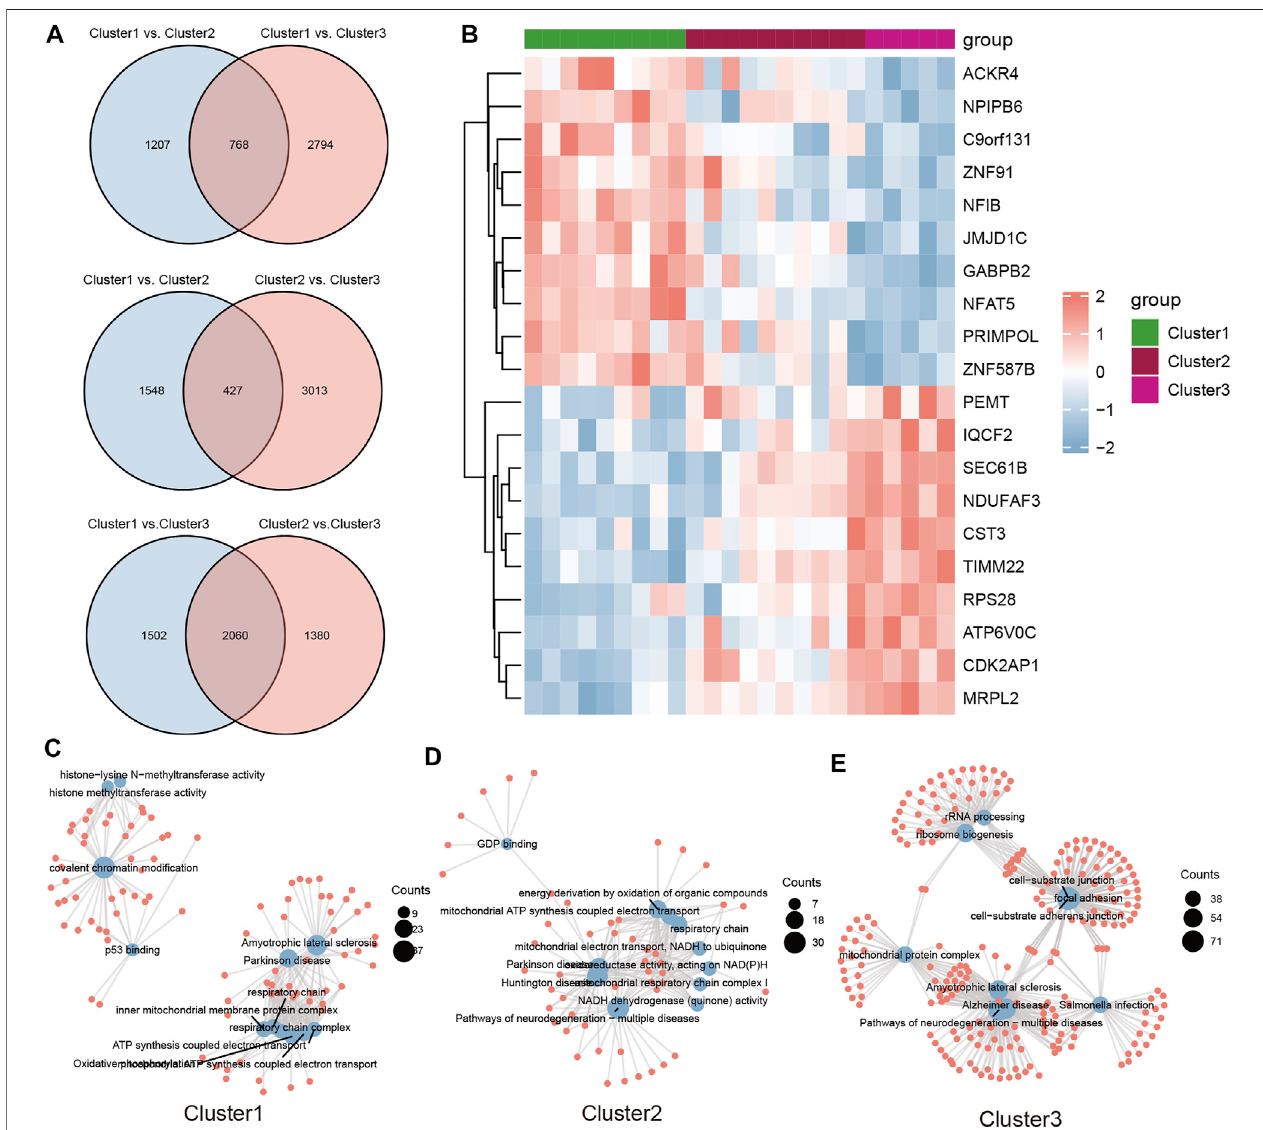
FIGURE 7 | The representative genes and functional analysis for each severe OSA subtype. (A) The differential genes were calculated for each of the two subclustersand intersectedusing the Venn plot. Cluster1, cluster2and cluster3consistedof768, 427and 2060representative genes,respectively. (B) Heatmap oftop 10 represented genes in all three subtypes. (C – E) GO and KEGG analysis of representative genes for each subcluster.